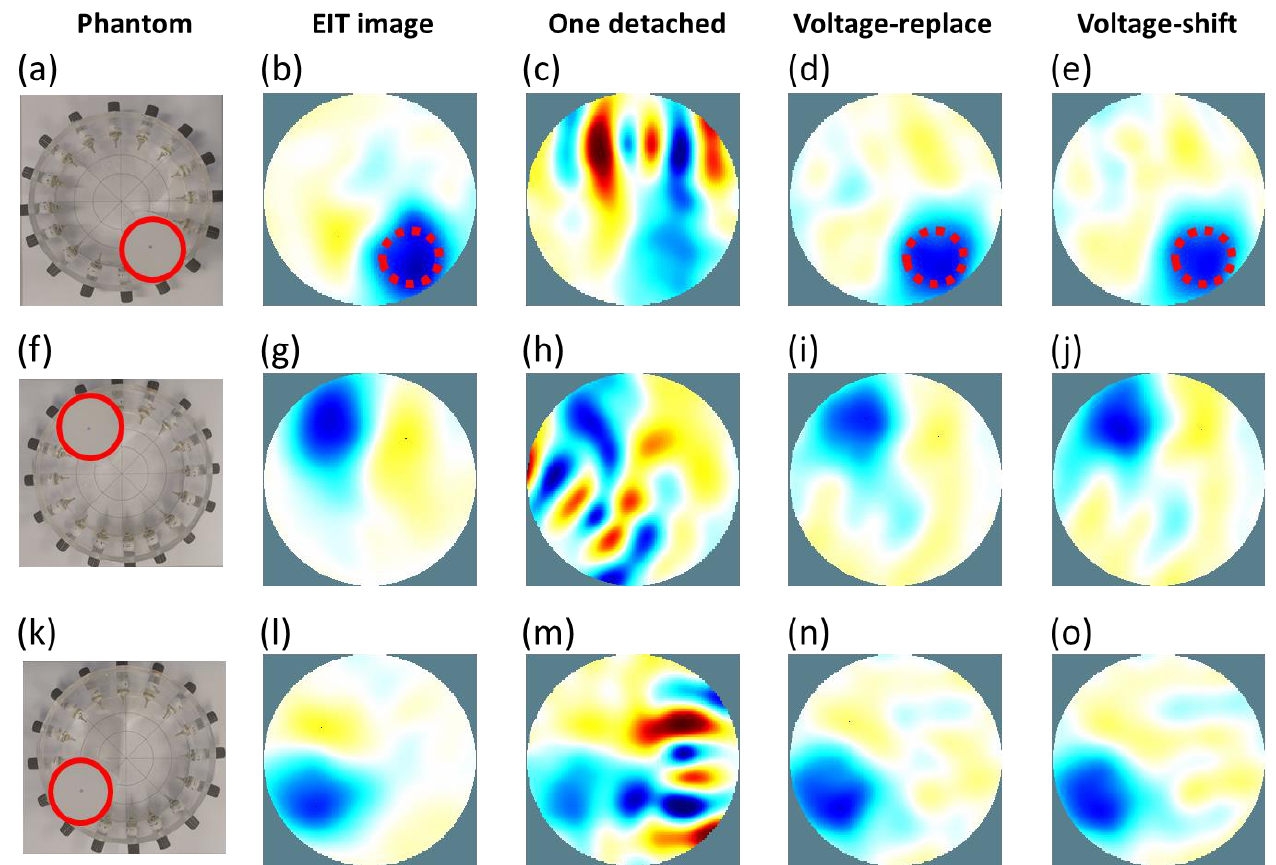
Figure 11. Experimental electrical impedance tomography (EIT) images. ( a ) Sample image with a circular inclusion at (x = 2.5 cm, y = −5.5 cm). ( b ) EIT image of ( a ). ( c ) EIT image of ( a ) with the first electrode detached. ( d ) Image reconstruction for ( c ) using the voltage-replace method. ( e ) Image reconstruction for ( c ) using the voltage-shift method. ( f ) Sample image with a circular inclusion at (x = −2.5 cm, y = 5.5 cm). ( g ) EIT image of ( f ). ( h ) EIT image of ( f ) with the seventh electrode detached. ( i ) Image reconstruction for ( h ) using the voltage-replace method. ( j ) Image reconstruction for ( h ) using the voltage-shift method. ( k ) Sample image with a circular inclusion at (x = −2.5 cm, y = −5.5 cm). ( l ) EIT image of ( k ). ( m ) EIT image of ( k ) with the fifth electrode detached. ( n ) Image